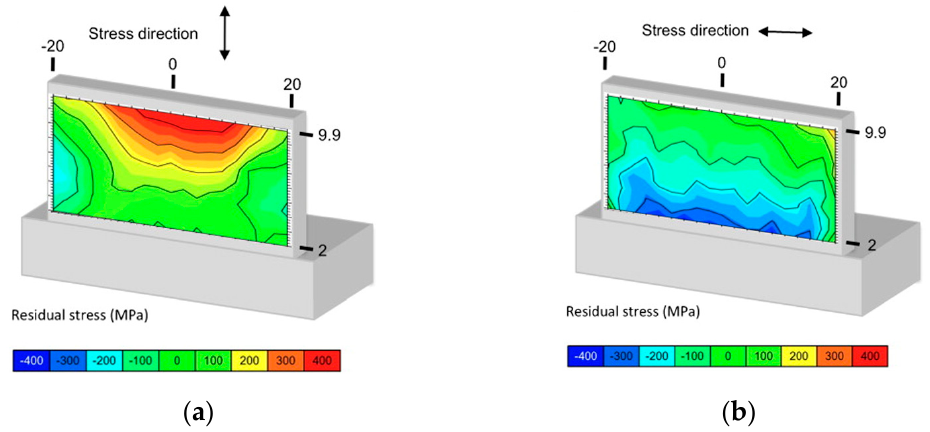
Figure 33. Residual stress distribution in the sample ( a ) along the building direction and ( b ) along the longitudinal direction (reproduced with permission from [149]; Copyright © 2011 Elsevier).